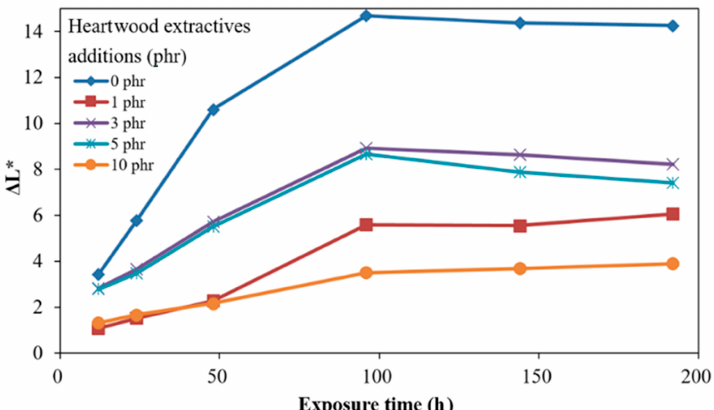
Figure 4. Time-dependent brightness difference ( ∆ L *) of ROL films with various A. confusa heart- wood extractive additions after UV